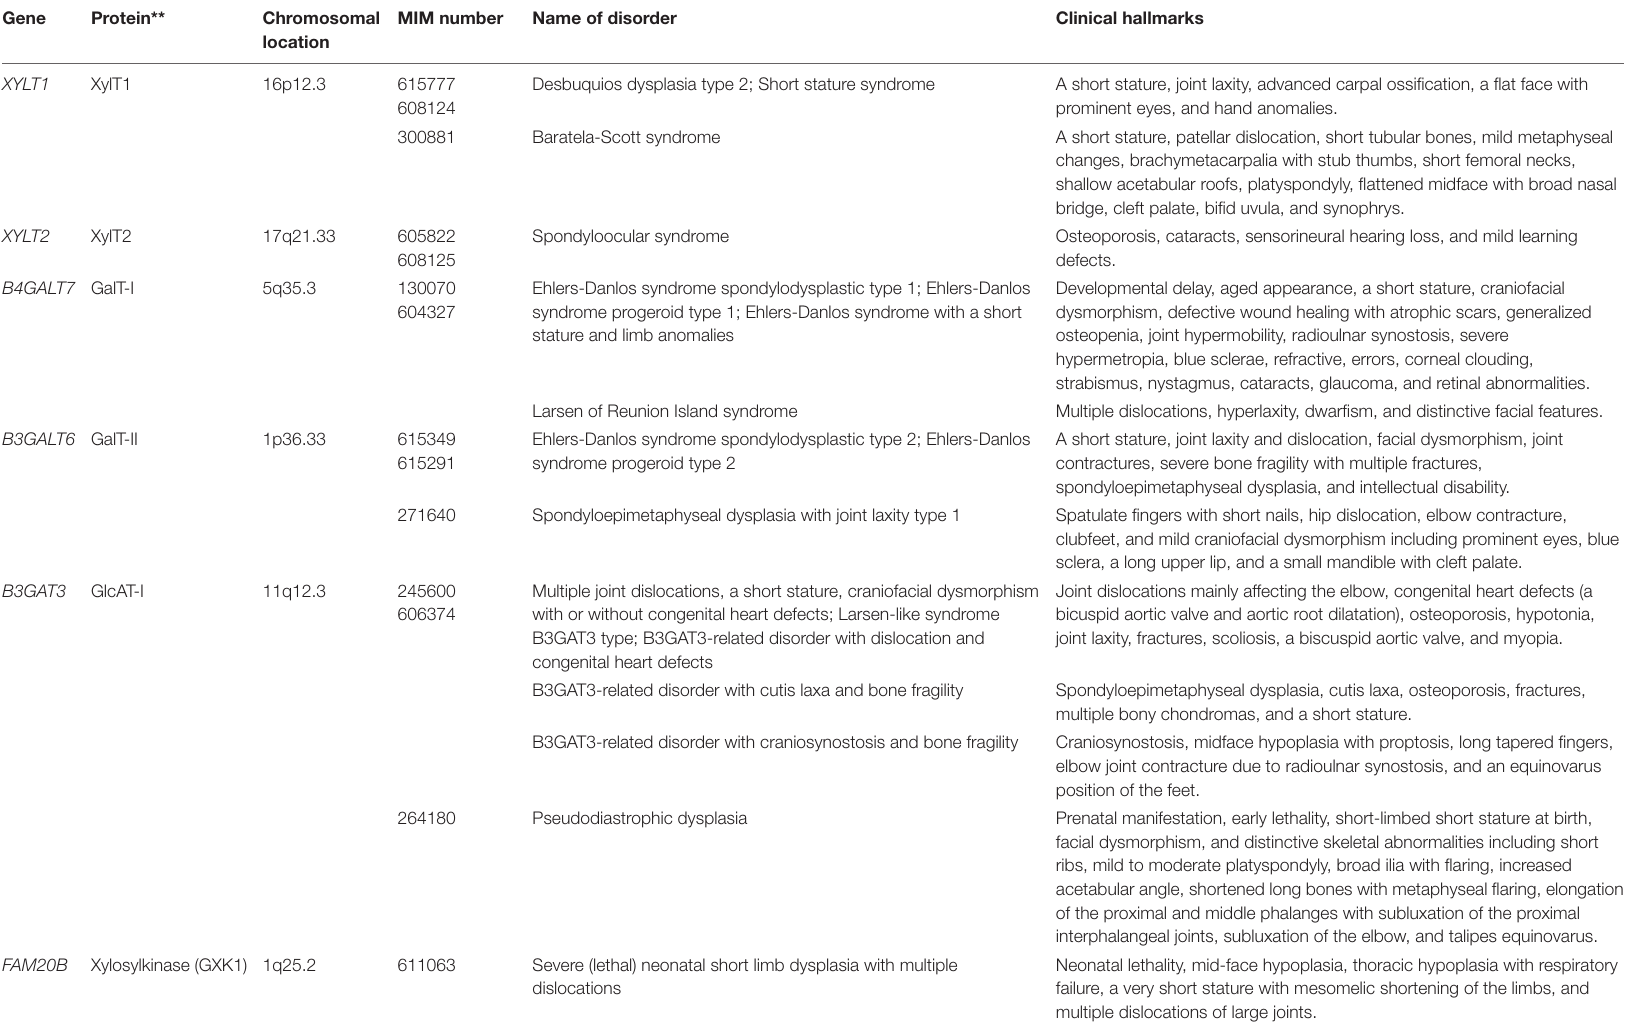
TABLE 1 | Congenital disorders of GAG-linker region tetrasaccharide deficiency*.